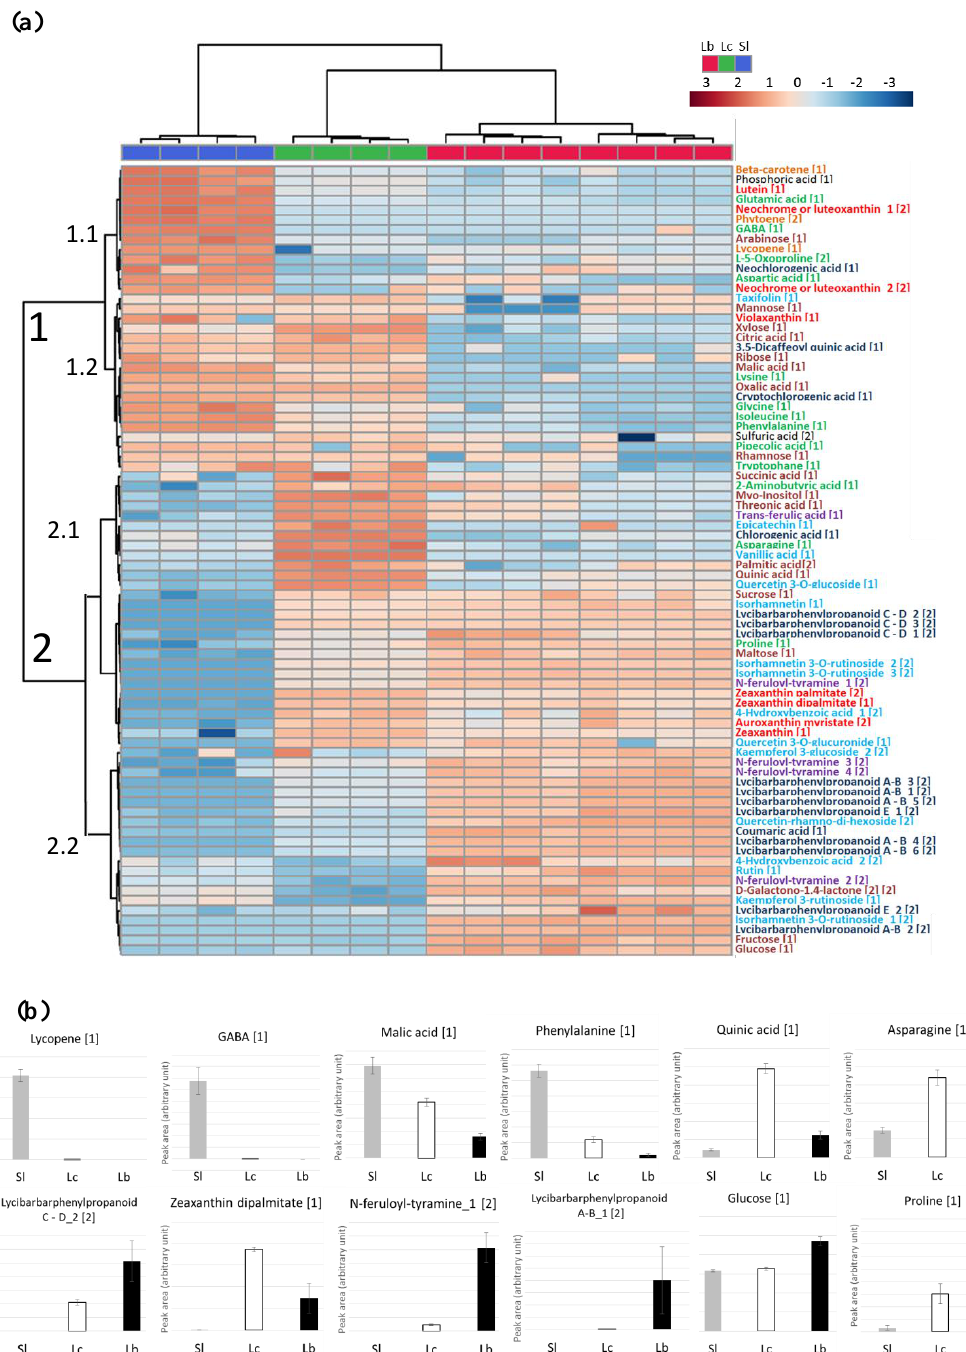
Figure 4. Metabolites discriminating the genotypes. ( a ) Heat map showing the expression (from blue for low content to red for high content) of the 80 relevant metabolites (Mann–Whitney p < 0.05 and identification confidence levels 1 and 2) in the 24 samples presented in rows. The dataset was composed of Log transformed and Pareto scaled values. The color code used for the accessions is blue for Sl, green for Lc and red for Lb. The metabolites appear in rows with a color code according to their chemical class: xanthophylls and derivatives in red; carotenes in orange; hydroxycinnamic acids and derivatives in deep blue; hydroxybenzoic acids, flavonols and derivatives in light blue; ferulic acid derivatives in purple; amino acids in green; organic acids and carbohydrates in brown. The identification confidence level is indicated between brackets after the compound name. The two classifications (accessions in columns and metabolites in rows) are based on Euclidian distances and Ward algorithm. ( b ) Mean and standard deviation bar plots of remarkable genotypic markers, ordinates are in arbitrary